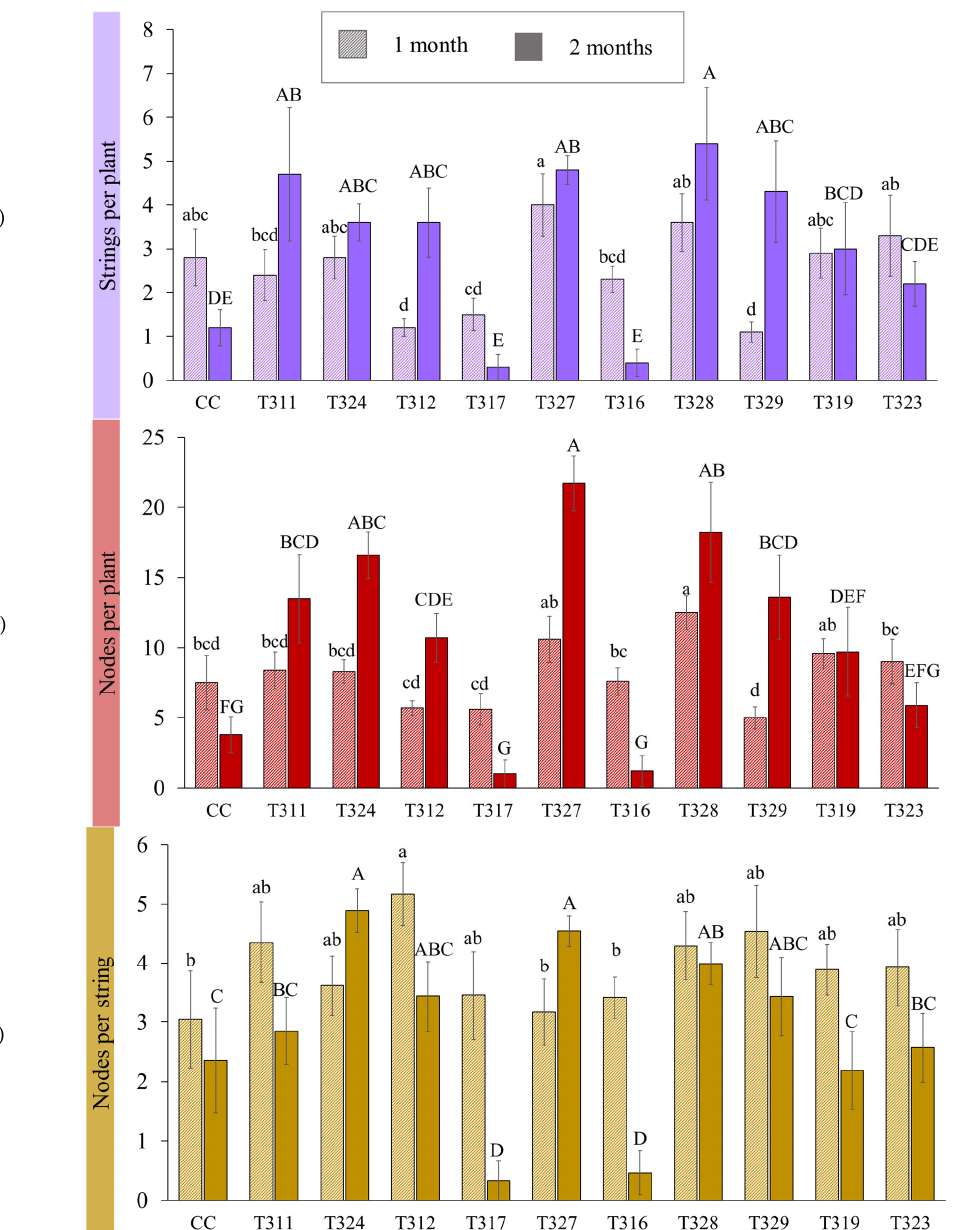
Figure 7. Growth development measures: ( a ) strings per plant, ( b ) nodes per plant, and ( c ) nodes per string (down). Mean values ( n = 10) ± SE. The mean values after one month are represented in stripes, and after two months in solid colors. Columns with different lower-case letters indicate significant differences after one month (Fisher’s LSD p < 0.05). Columns with different capital letters indicate significant differences after two months (Fisher’s LSD, p < 0.05). T. brevicompactum T323 and T. spirale T319 showed low growth promotion abilities in hop plantlets without significant differences from CC plants. The isolates of T. rossicum T316 and T. virens T317 presented the lowest values of plant growth development, with no significant differences to CC plants regarding strings and nodes per